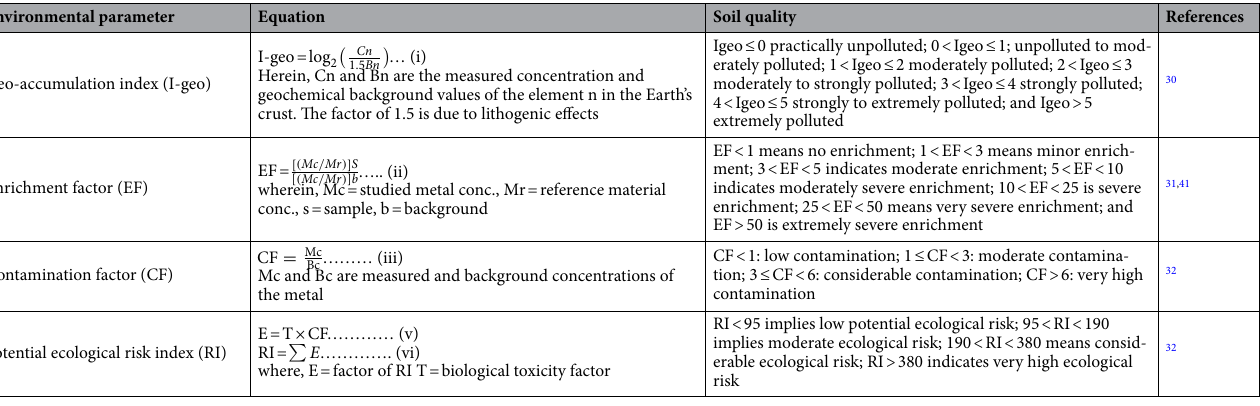
Table 2. Description of the soil contamination